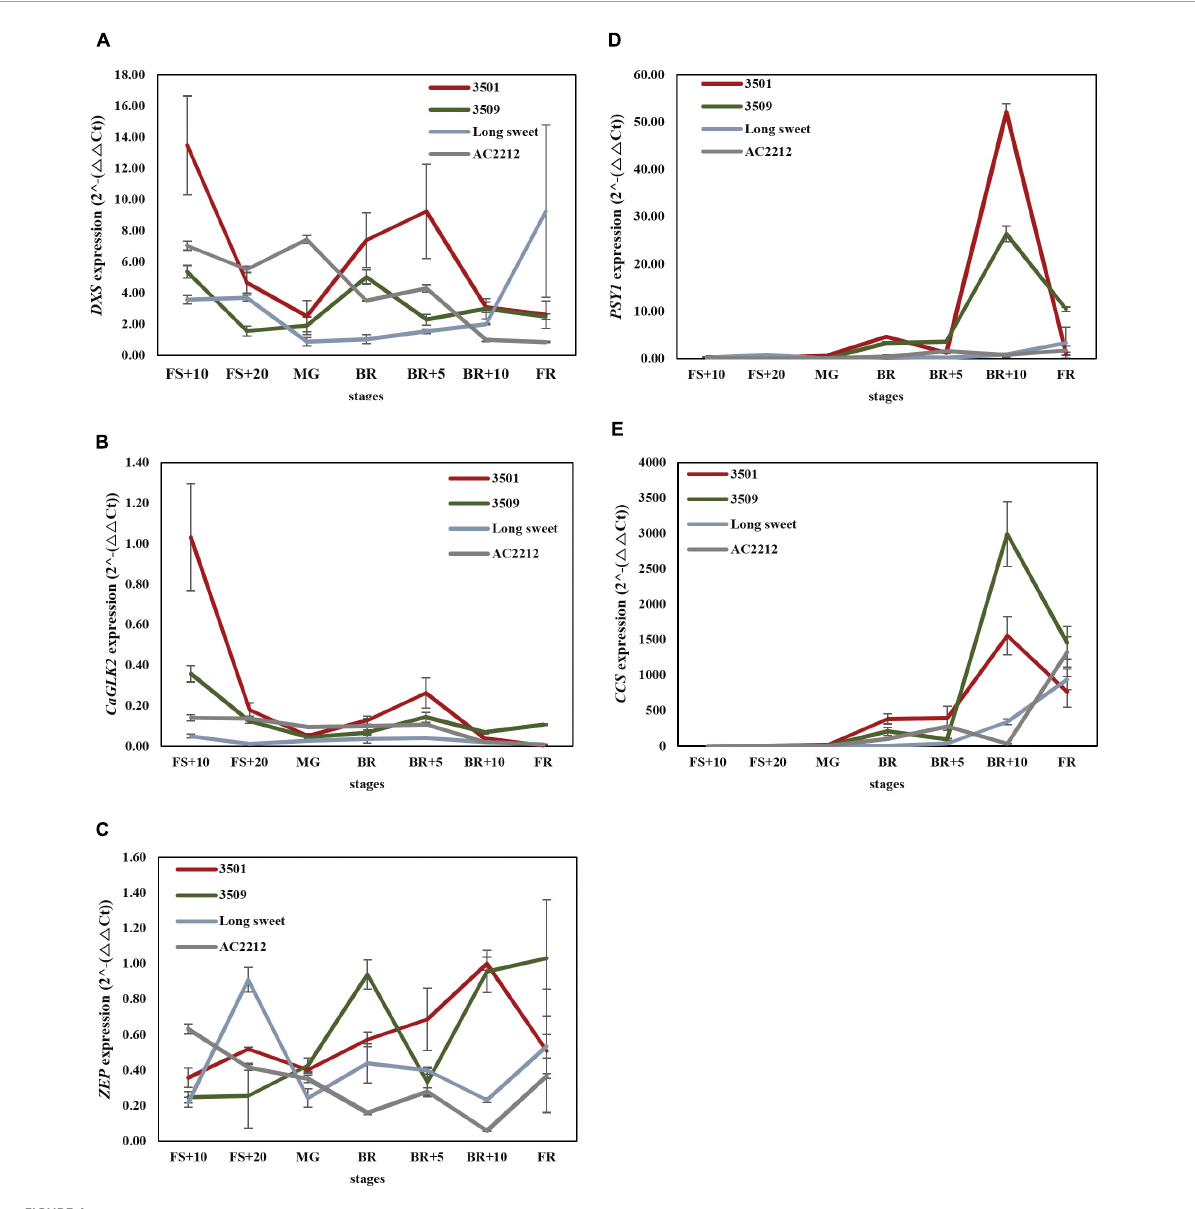
FIGURE4 Expression analysis of (A) DXS , (B) CaGLK2 , (C) ZEP , (D) PSY1 , and (E) CCS . FS, fruit set, MG, mature green, BK, breaker stage, FR, full red color fruit. Red, green, light blue, and gray lines indicate expression patterns of “3501,” “3509,” “Long Sweet,” and “AC2212,” respectively.